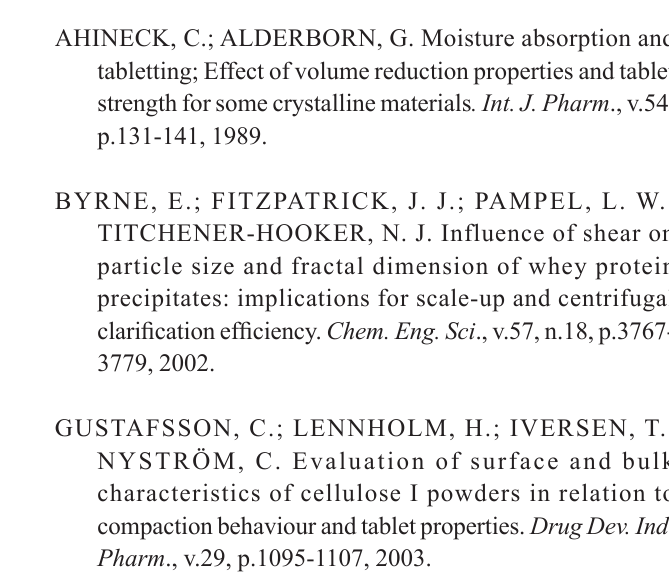
FIGURE 4 - Plots of (K-Ko) versus number of taps N of chloroquine phosphate (CQ) with lactose (LAC) and dicalcium phosphate (DCP) at a ratio of